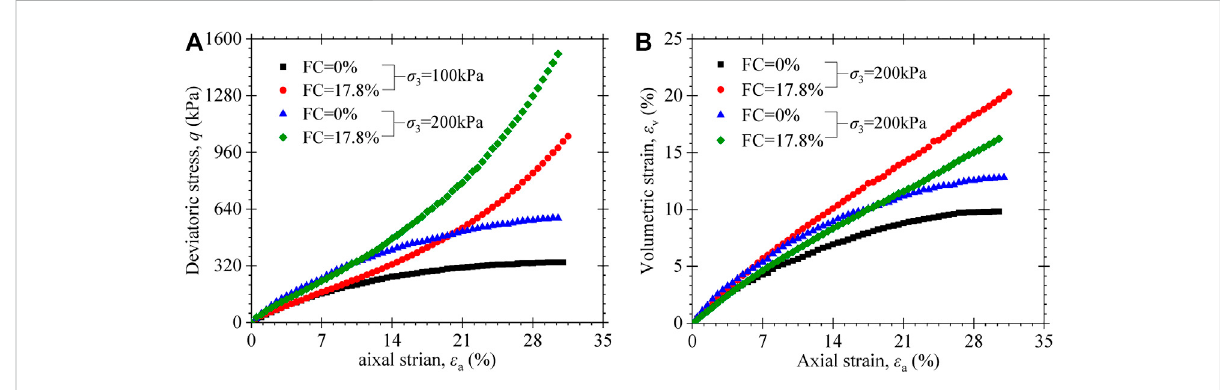
FIGURE 5 Triaxial test results of MSW specimens for different fi brous contents: (A) deviatoric stress vs. axial strain; (B) volumetric strain vs. axial strain.